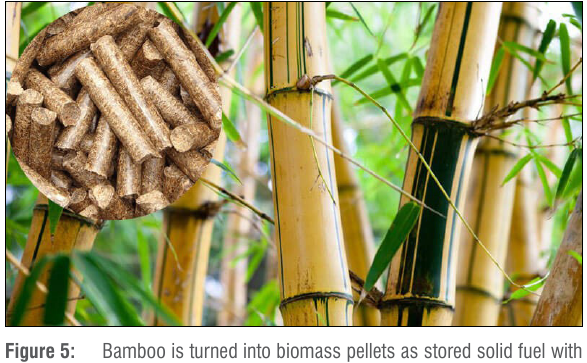
Bamboo is turned into biomass pellets as stored solid fuel with